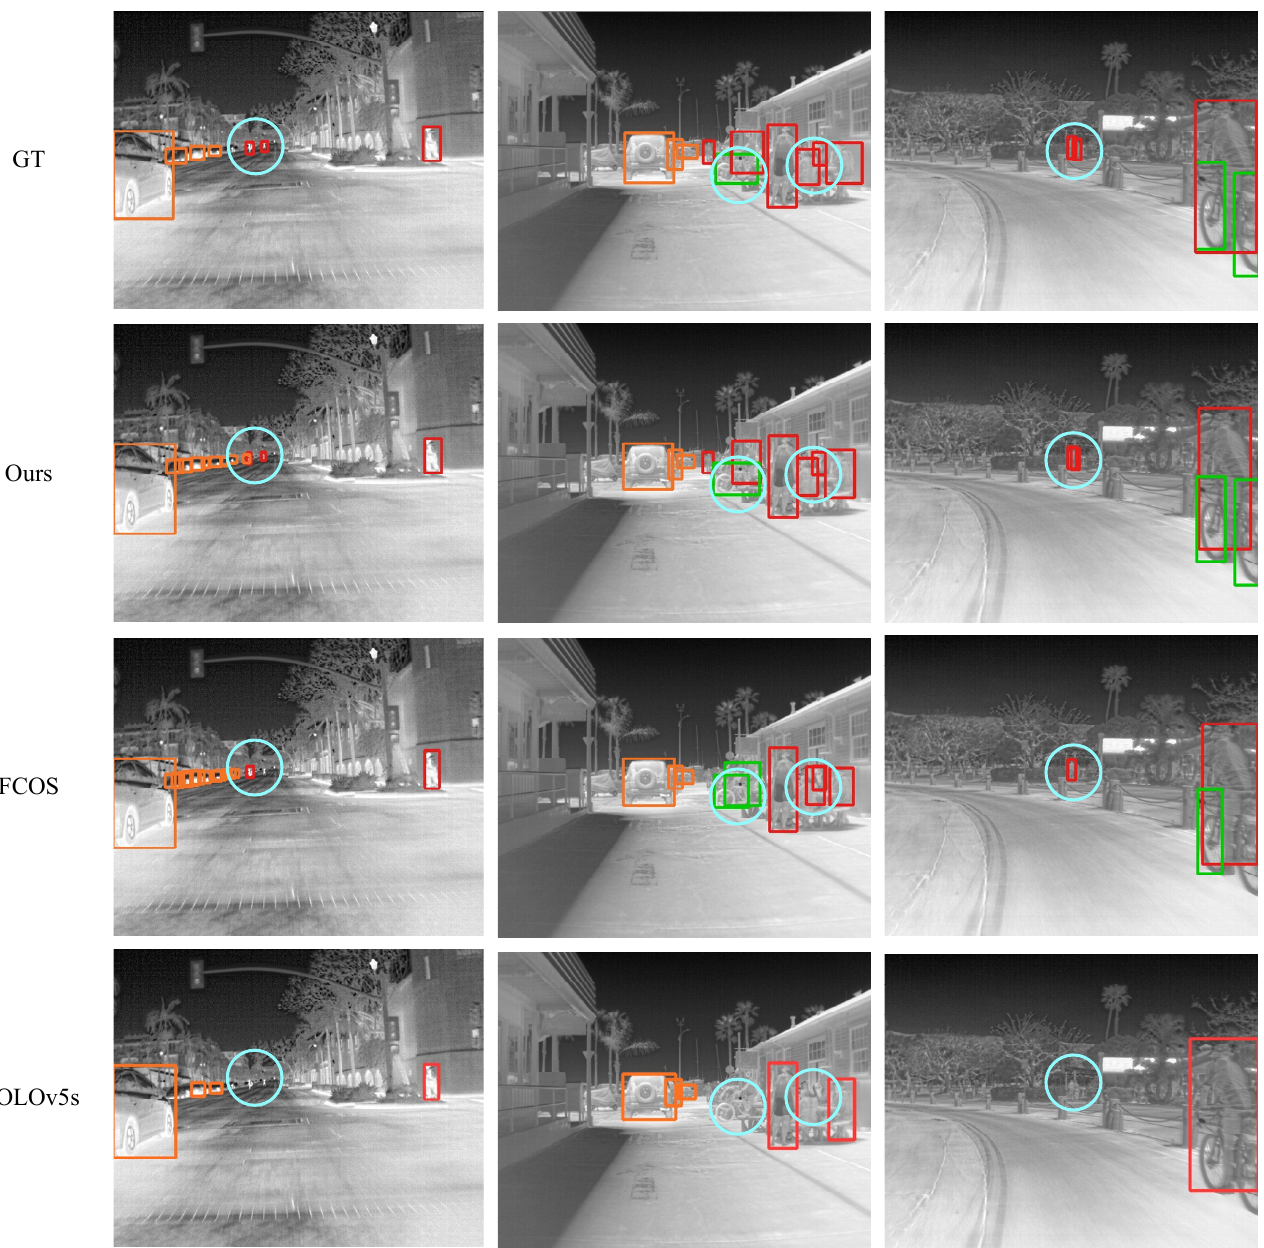
Figure 7. Detection effects diagram of each popular method. From top to bottom is the real label, the proposed method results, FCOS results, and YOLOv5s results.